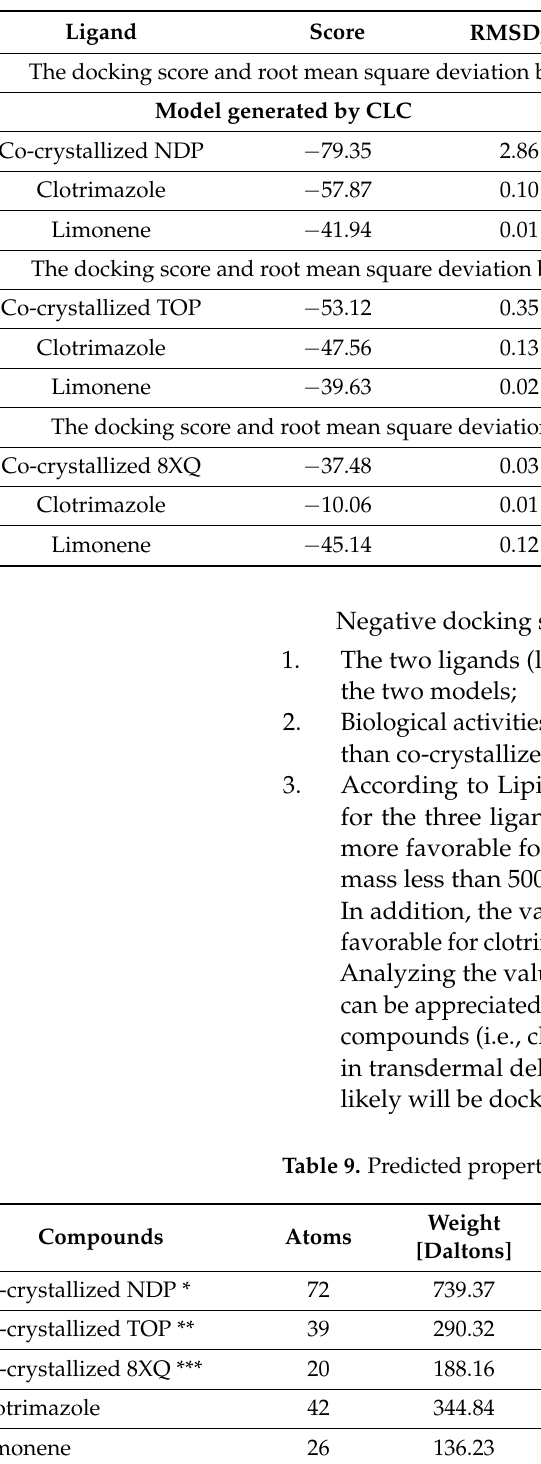
Table 8. The docking score and root mean square deviation between the docked ligands on the specific binding sites from the three microorganisms.